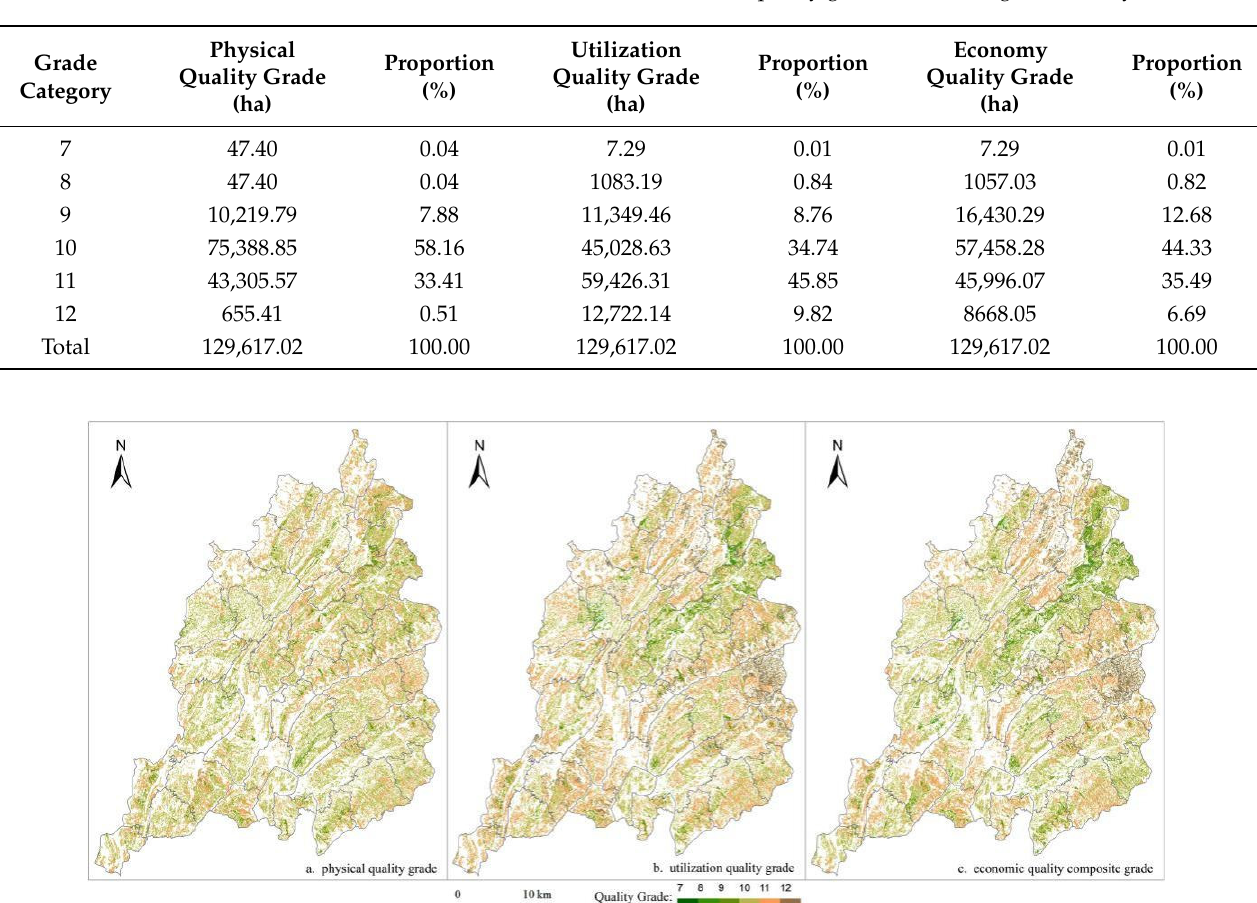
Figure 3. Spatial distribution map of the cultivated land quality grade of the study area.